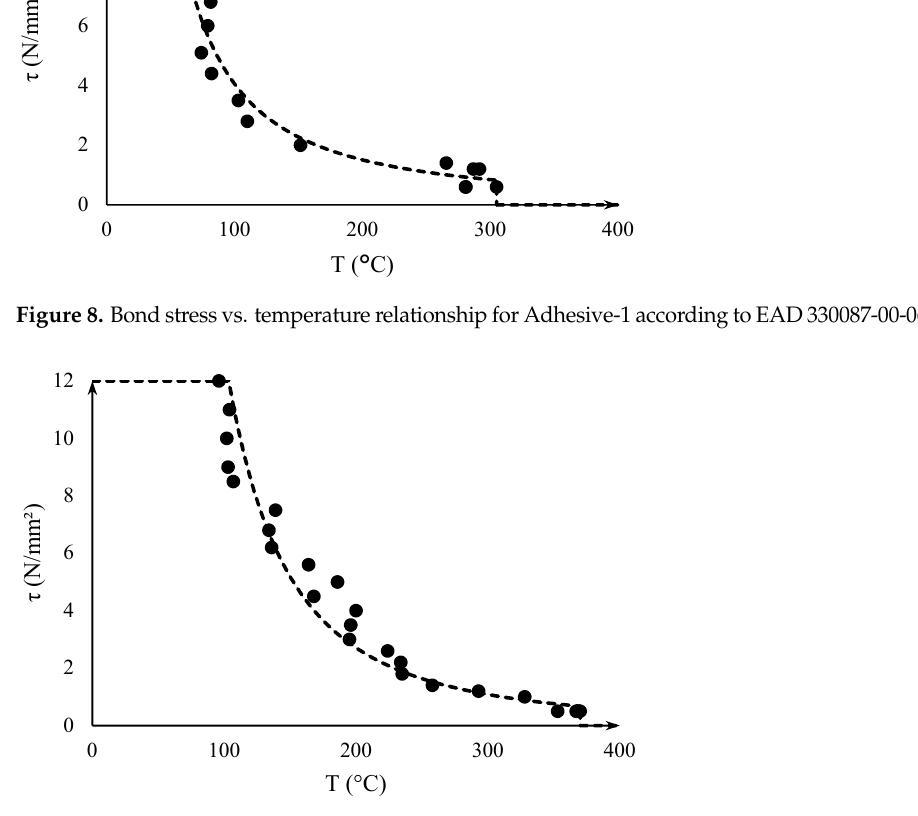
Figure 9. Bond stress vs. temperature relationship for Adhesive-2 according to EAD 330087-00-0601 [15].